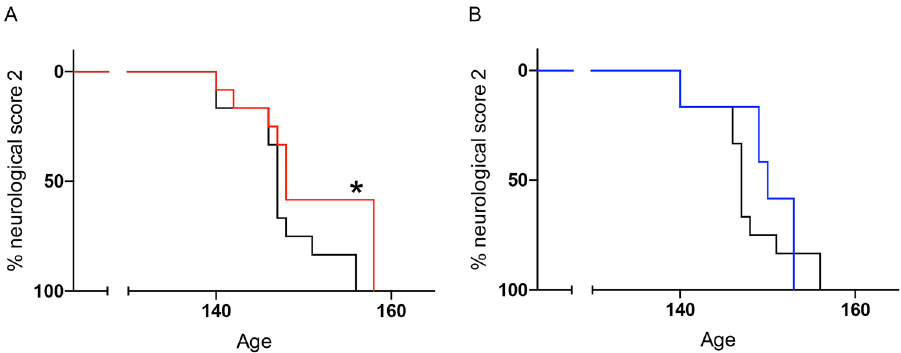
Figure 2. Oxaloacetate treatment from the presymptomatic stage delays the toe-curling phenotype (neurological score of 2) of SOD1 G93A mice. ( A ) Oxaloacetate treatment from the presymptomatic stage (60 days old, red) delayed the median of the onset age of a neurological score of 2 by one day compared to the control group of non-injected SOD1 G93A mice (black, p = 0.0448, log-rank test). ( B ) Oxaloacetate treatment from the symptomatic stage (110 days old, blue) did not alter the median onset age of a neurological score of 2. ( p = 0.3420, log-rank test). The graphs show Kaplan–Meier curves with n = 12 mice per group. These graphs contain mice that are identical to the mice in Fig.